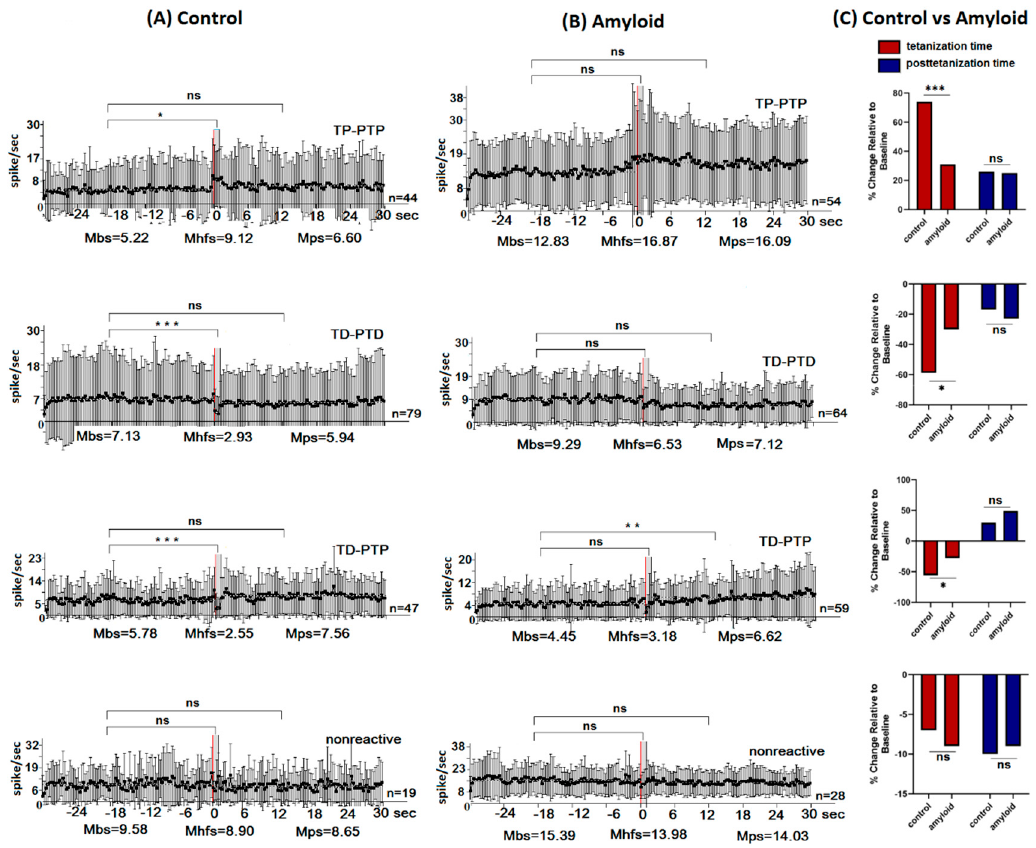
Figure 2. The average peri-stimulus time histogram of spike frequency in hippocampal neurons. ( A , B ). The mean peri-stimulus frequency diagrams built on the basis of pre-stimulus and post-stimulus manifestations of spike activity of single hippocampal neurons to high-frequency stimulation of nucleus basalis magnocellularis in a real-time 30 s before stimulation (Mbs), 30 s post-stimulation (Mps) and during high-frequency stimulation (Mhfs), exhibiting the specified types of responses (TP-PTP, TD-PTD, TD-PTP,) and nonreactivity in the control ( A ) and amyloid ( B ) groups. The data are presented as mean ± SD; n = number of neurons. The statistical significance of a di ff erence from baseline (Mbs) was estimated according to the unpaired Student’s t -test, * p < 0.05, ** p < 0.01, and *** p < 0.001. ( C ). The bar diagrams show the average % changes relative to the baseline (Mbs, zero level) in responses of tetanization time (red) and post-tetanization time (blue) in control vs. amyloid groups in the population of neurons with a given type of response. Statistical significance was calculated using Fisher’s exact test, * p < 0.05.